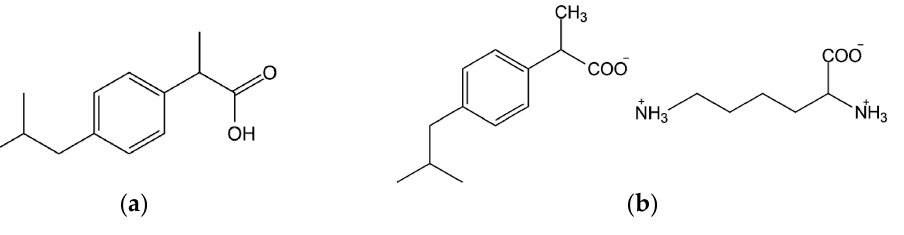
Figure 9. ( a ) Ibuprofen; ( b ) ibuprofen lysinate.